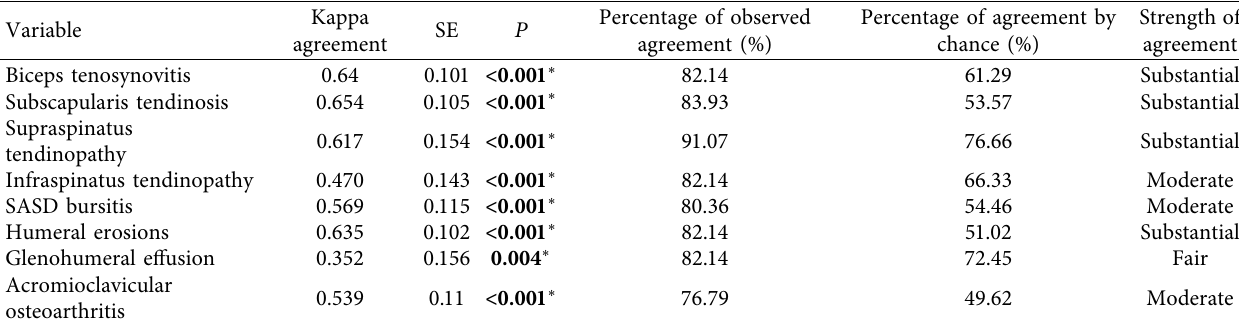
Table 6: Agreement between ultrasound and magnetic resonance imaging in detecting shoulder pathologies in the study HD patients ( n � 56